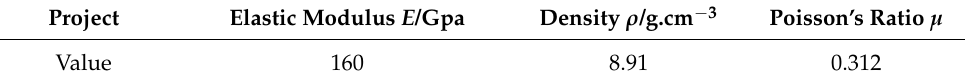
Table 1. Material parameters of the shear pin.